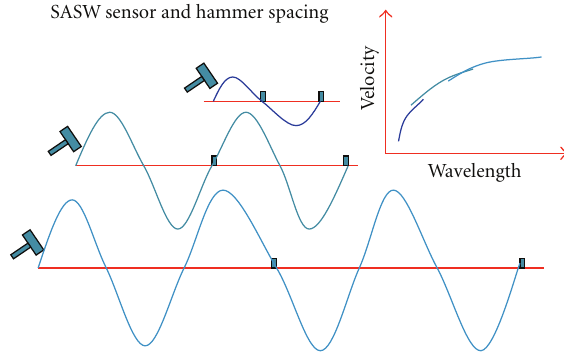
Figure 3: Bulldozer coupled with dynamometer to measure anchor holding capacity.